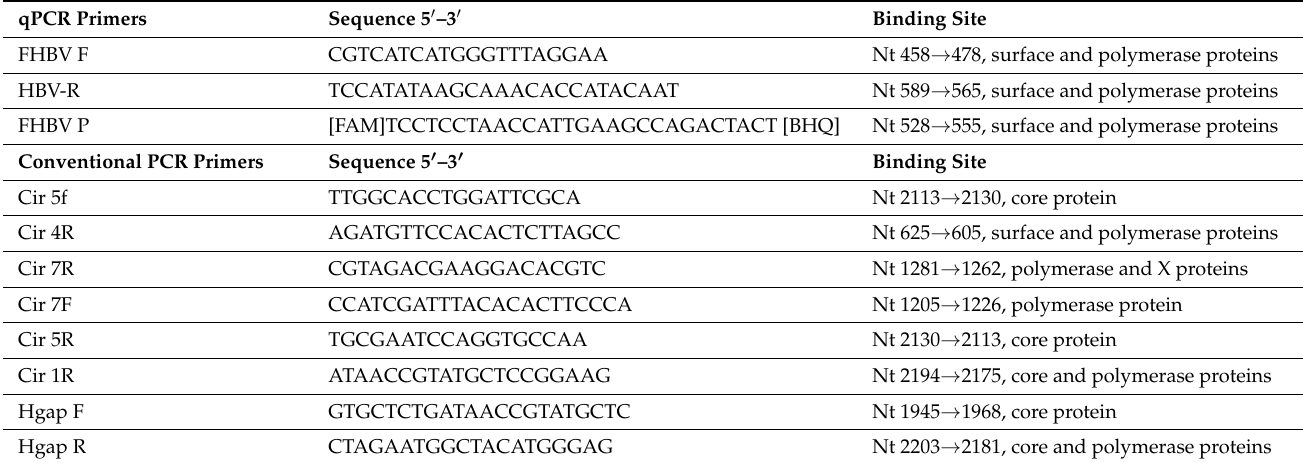
Table 2. PCR primers used in this study. All the primer sets listed above were used in this study for PCR product analysis. Primers from